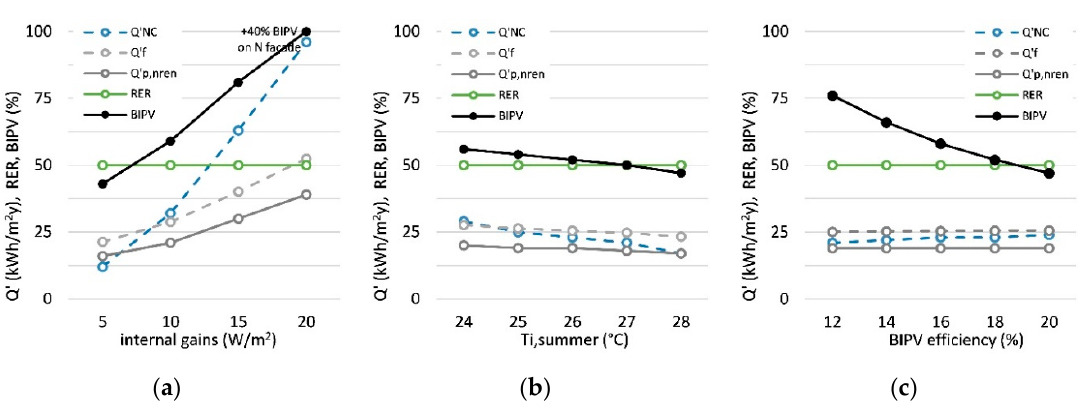
12 of 18 buildings with different BIPV facade structures and are compared to buildings with double-glazed facades without BIPV. ( a ) ( b ) ( c ) Figure 8. Energy efficiency and nZEB indicators for the buildings constructed with advanced glazed and BIPV facade structures in Type I ( a ), Type II ( b ), and Type III ( c ) buildings in Zurich; note that the area of PV cells in the BIPV glassed facade structure is 60% of the total facade structure area. From the results, it can be concluded that all buildings with advanced glazing can meet the target values of nZEB indicators. The most demanding indicator is RER ; 65% (Type I) to 50% (Type III) of total glassed facade areas need to be built with BIPV facade structures to fulfil target values. Expressed in the area of BIPV facade structures, it is found that 650 m 2 of BIPV structures are needed to achieve RER equal to 50% in the case of Type I buildings, 790 m 2 in the case of Type II buildings, and 990 m 2 of BIPV structures in the case of Type III buildings. As in the previous case, energy needs for heating are below the target value of energy needs for heating Q’ NH in all cases, regardless if double glazing or advanced multi-pane glass facade structures are installed. The energy needs for heating correspond to energy efficiency class A of Type I buildings in all cases, while four-pane multi- layer BIPV facade structures must be installed in the case of Type II and Type III buildings. Advanced facade structures significantly decrease the non-renewable primary energy Q’ p,nren needed for the operation of all building types in comparison to double-glazed facades, but also in this case, no